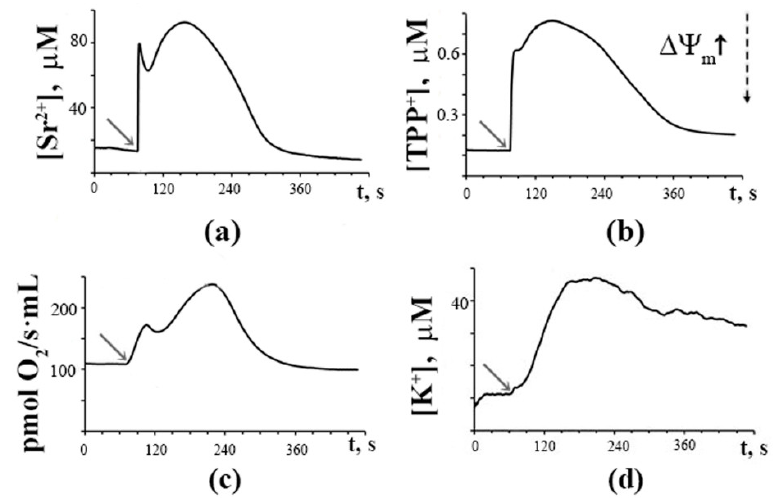
Figure 1. Single pulse addition of Sr 2+ (shown by the arrow) induces rapid reversible changes in Sr 2+ fluxes ( a ), membrane potential ( b ), respiratory rate ( c ), and slow changes in K + fluxes ( d ) in the suspension of rat liver mitochondria. The incubation medium contained 20 mM sucrose, 1 mM KCl, 1 µ M TPP + , 1 µ M CsA, 1 µ M rotenone, 5 mM succinic acid, and 12.5 mM Tris (pH 7.3). Addition: 45 nmol SrCl 2 /mg of mitochondrial protein. The dotted arrow indicates a change in the membrane potential. The typical traces are presented ( n = 7).